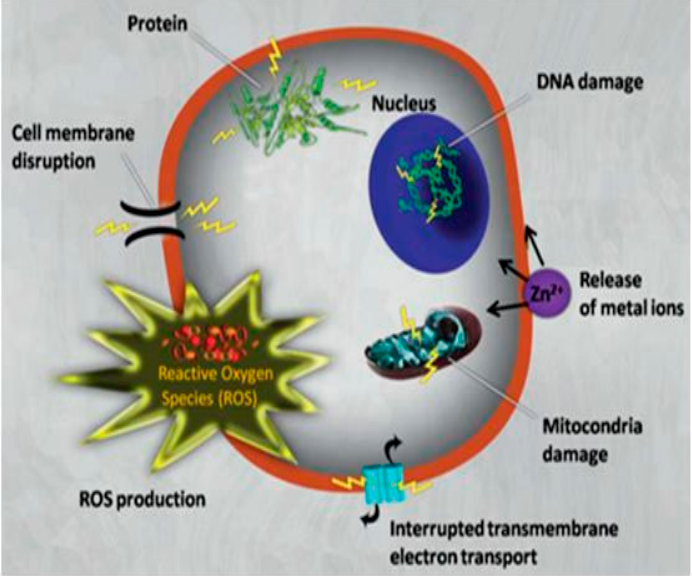
Figure 1. Mechanisms of antimicrobial activity of ZnO nanoparticles. Adapted from [27], copyright 2012, with permission from Elsevier.